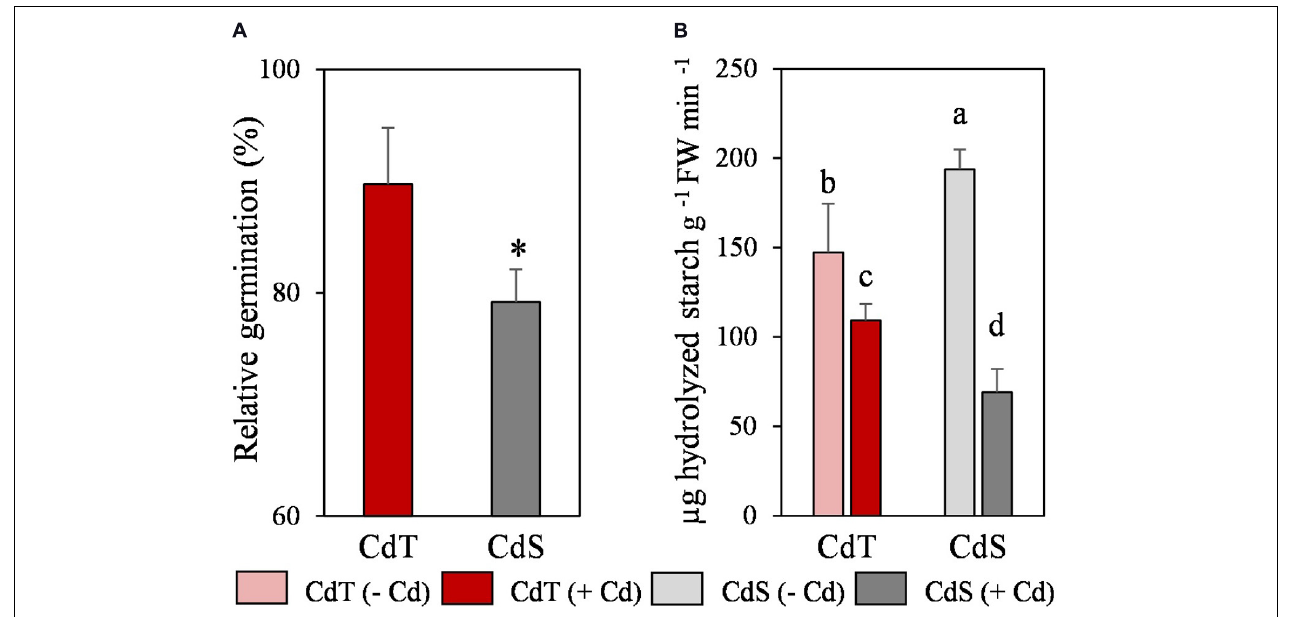
FIGURE 5 | Relative germination in the presence of Cd (200 µ M CdCl 2 , 72 h) (A) and α -amylase activity in cotyledons (B) of M. truncatula cultivars CdT (tolerant) and CdS (sensitive). Mean values ± standard deviation are represented. * Indicates significant differences between presence and absence of Cd for each accession [Pearsons’s chi-squared test ( χ 2 ), n = 4]. Different letters indicate significant differences between cultivars and treatments (Tukey HSD test, p ≤ 0.05, n = 4–6).